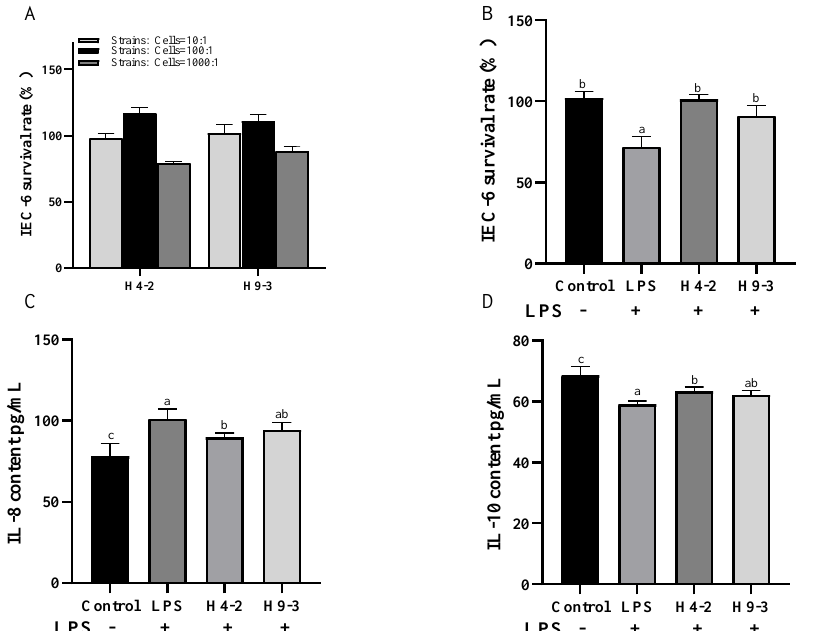
Figure 1. Viability of IEC-6 cells co-culturing with B. breve at different ratios of bacteria to cells ( A ) as well as survival rates ( B ), IL-8( C ) and IL-10 ( D ) secretion of IEC-6 exposed to lipopolysaccharides (LPS) co-incubating with B. breve . Different lowercase letters (a, b, c) above the columns indicate significant differences ( p < 0.05), and the same superscript letters indicate that the differences between the values are not statistically significant ( p > 0.05).